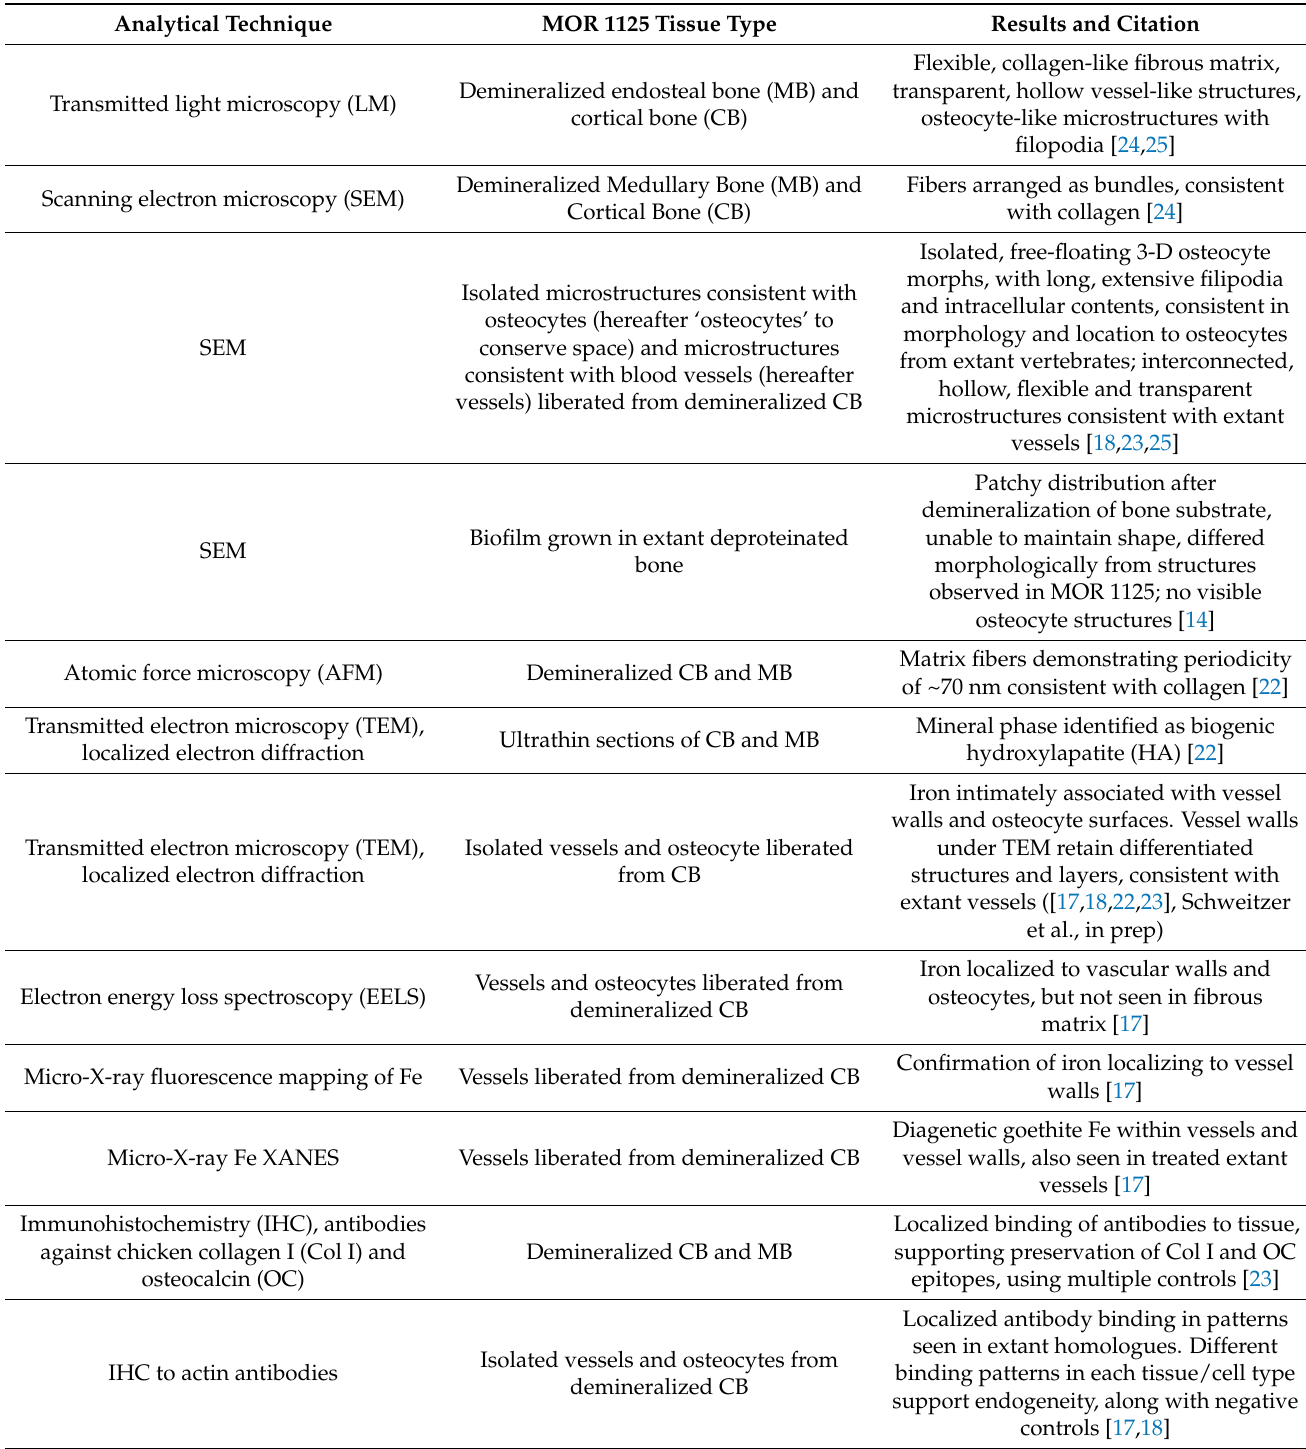
Table 1. List of various techniques applied and results obtained from molecular/chemical studies of the T. rex MOR